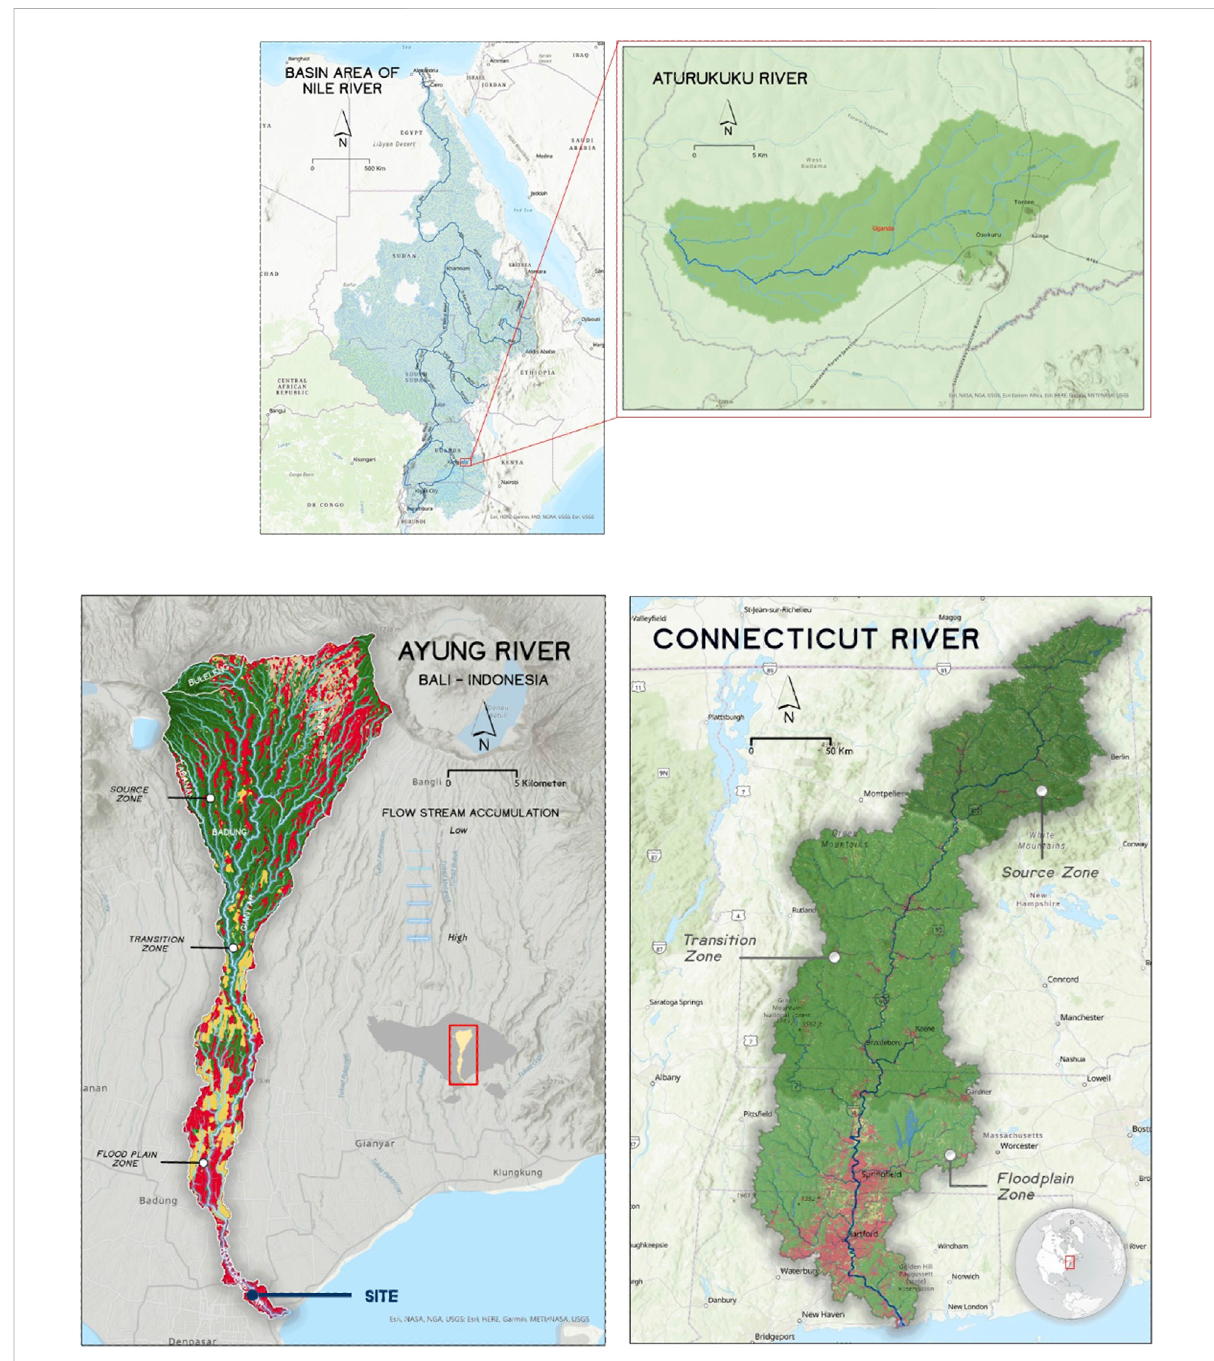
FIGURE 1 MapsshowingthelocationsoftheAturukukuRiverinUganda,theAyungRiverinIndonesia,andtheConnecticutRiverintheUnitedStates(Map credit: Muhammad